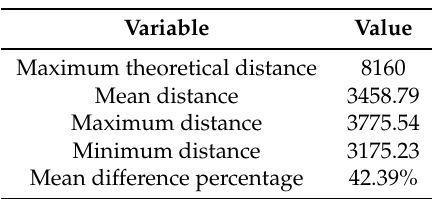
Table 6. Distance between the same 1000 1-kiB packets on the same topic encrypted with the same encryption